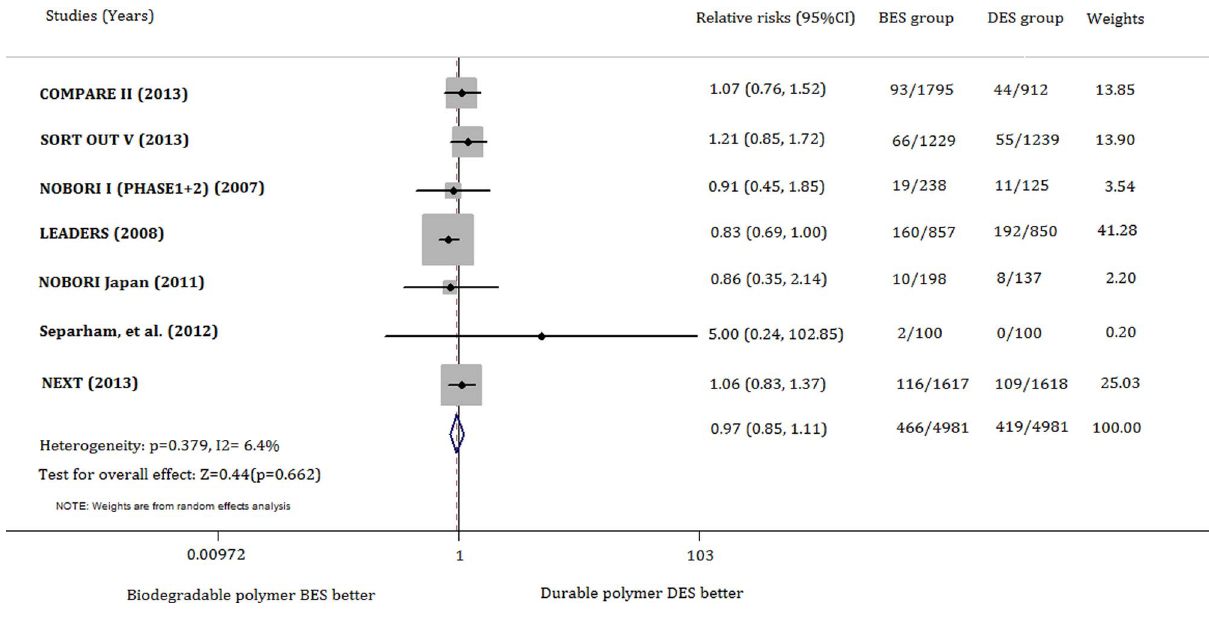
Figure 2. Forest plot for MACE associated with biodegradable polymer BES versus durable polymer DES. The squares and the horizontal lines indicate the relative risks, and the 95% confidence intervals for each trial included the size of each square is proportional to the statistical weight of a trial in the meta-analysis. A diamond indicates the effect estimate derived from meta-analysis, with the center indicating the point estimate, and the left and the right ends are the 95% CI. MACE: major adverse cardiac events; BES: biolimus-eluting stents; DES: drug-eluting stents.